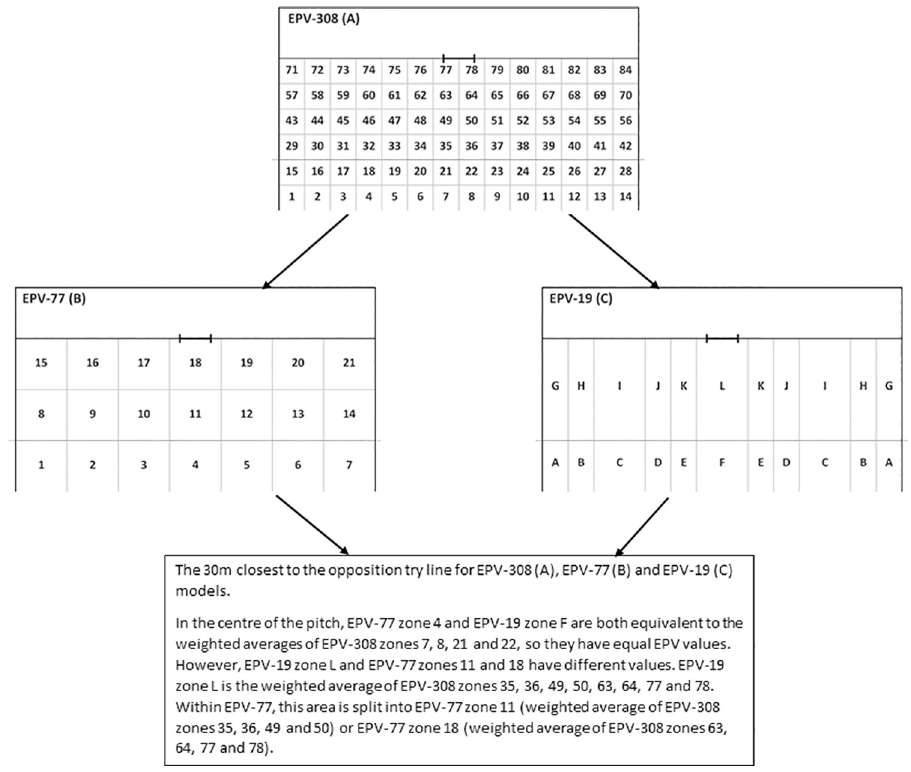
Fig 1. Depiction of similarities and differences between EPV-308 (A), EPV-77 (B) and EPV-19 (C) in the 30m closest to the opposition try line. Each zone from the EPV-77 and EPV-19 is a weighted average of the EPV-308 zones they are composed of. Dotted line represents the opposition 20m